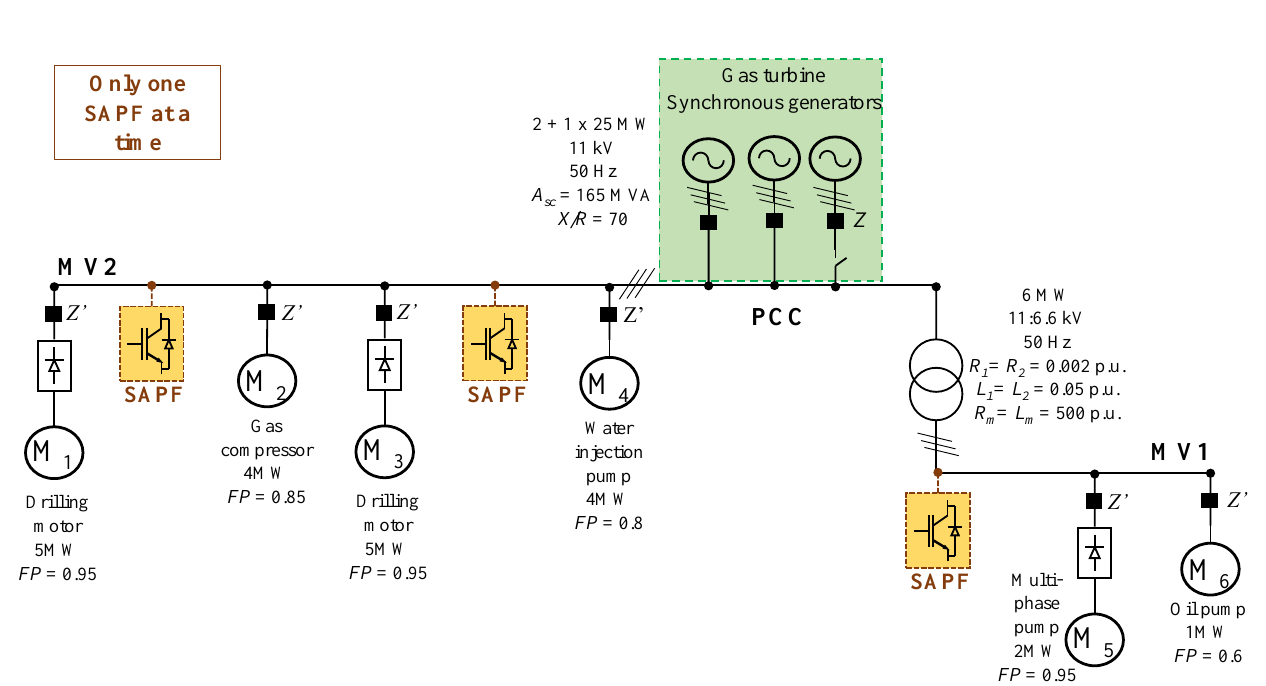
Figure 1. Diagram of a typical power grid of an offshore oil and gas